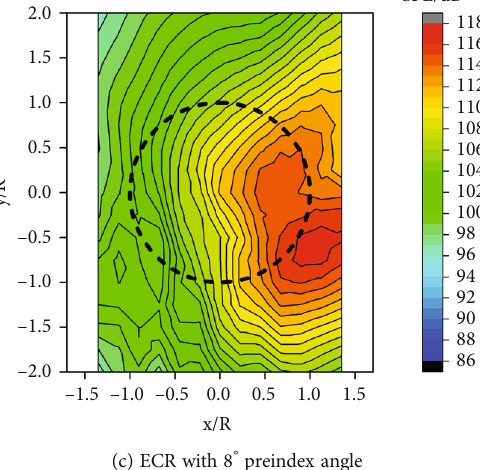
Figure 9: Sound pressure level noise contours (6 th -40 th blade passage